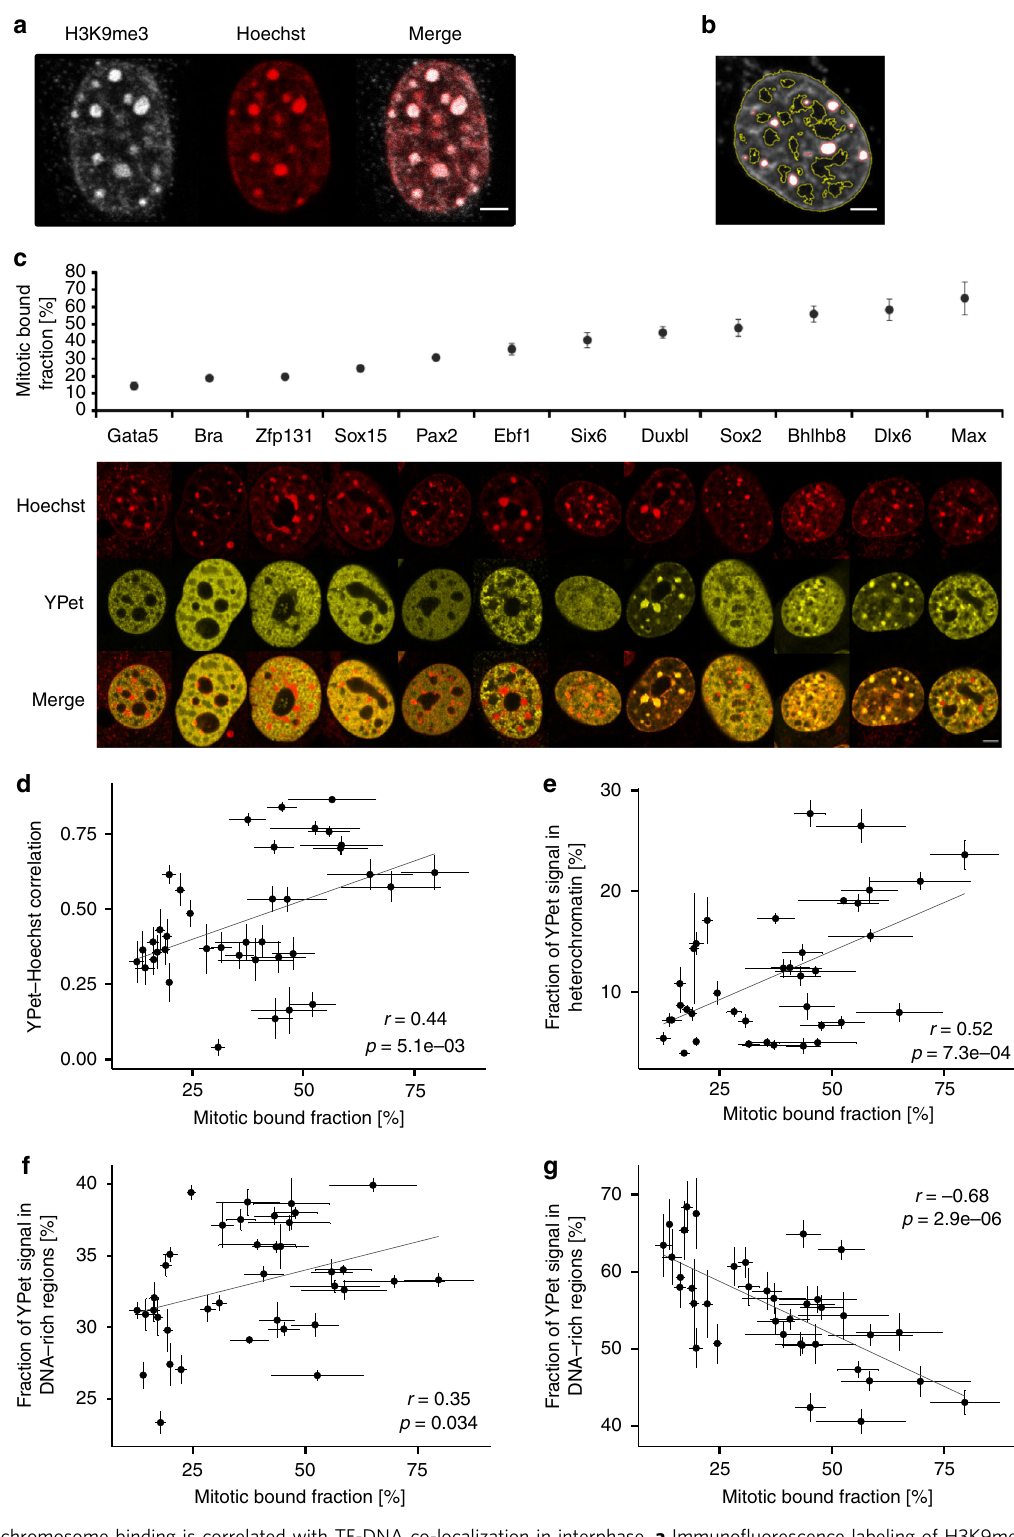
Fig. 2 Mitotic chromosome binding is correlated with TF-DNA co-localization in interphase. a Immuno fl uorescence labeling of H3K9me3 (Abcam, #ab8898) and Hoechst staining of a NIH-3T3 nucleus. Scale bar: 3 µ m. b Automatic detection of regions displaying different densities of DNA: Heterochromatic (circled in red), DNA-rich (between red and yellow circles), or DNA-poor (circled in yellow). Scale bar: 3 µ m. c Examples of TF-YPet interphase localization in NIH-3T3 cells, as compared to Hoechst staining and ranked by mitotic bound fraction (for n values see Supplementary Table 2). Bra Brachyury. Scale bar: 5 µ m. d Correlation between the TF-YPet/Hoechst co-localization (MAFK: n = 8, NANOG and BHLHB8: n = 11, others: n = 10) and the mitotic bound fraction. e - g Correlation between the mitotic bound fraction and the fraction of YPet signal co-localized with heterochromatic regions ( e ), DNA-rich regions ( f ), and DNA-poor regions ( g ). n = 10. Error bars: SEM. r -values ( r ) and p -values ( p ) are based on Pearson